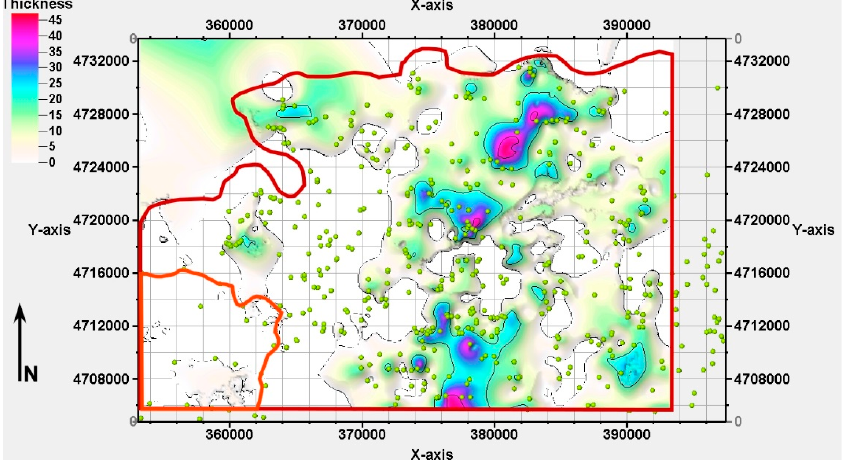
Figure 10. Isopach map of the Sub-Tiskilwa Sand/Gravel. The study area is outlined in red and Winnebago Formation that occurs at land surface is outlined in orange. Green dots represent water- well locations. Thickness is in meters.